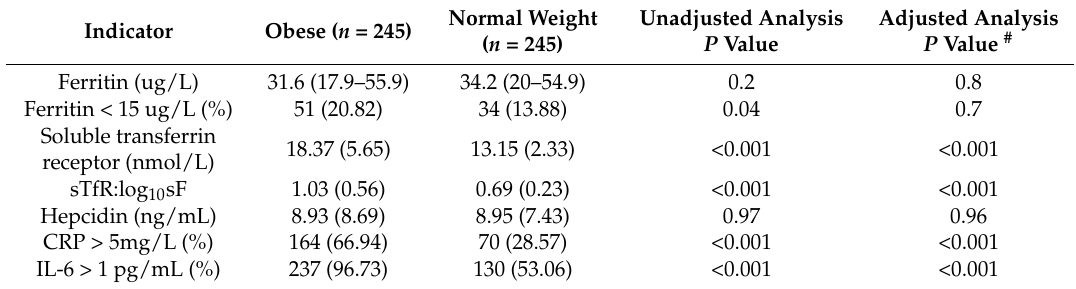
Table 2. Maternal inflammatory and iron status indicators of obese and normal weight pregnant